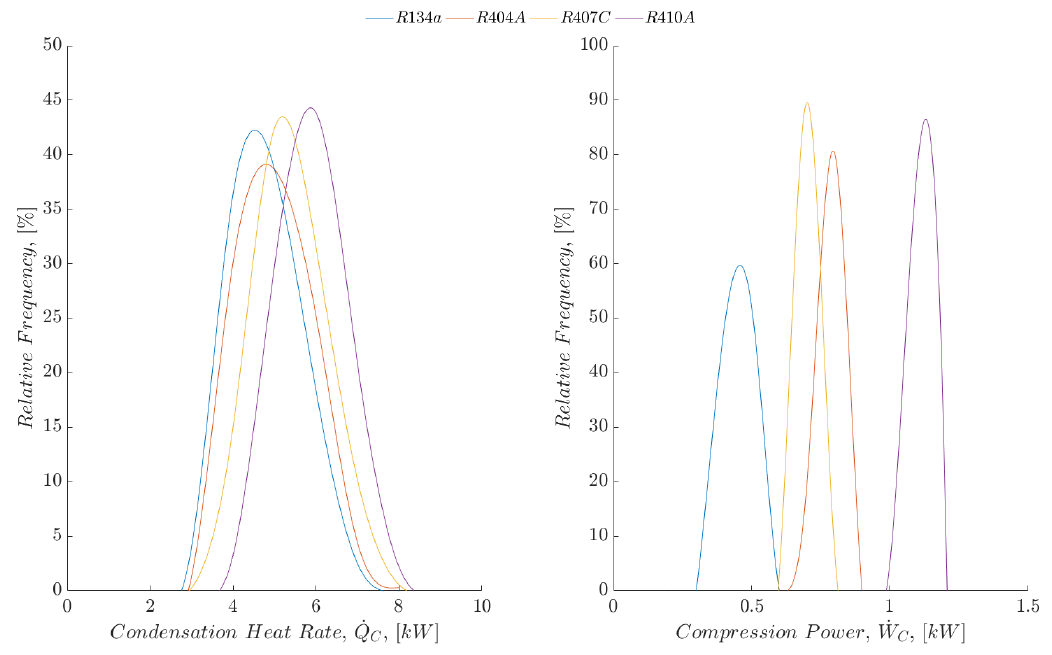
Figure 24. Relative frequency of the energy exchange of the optimized system for all refrigerants.